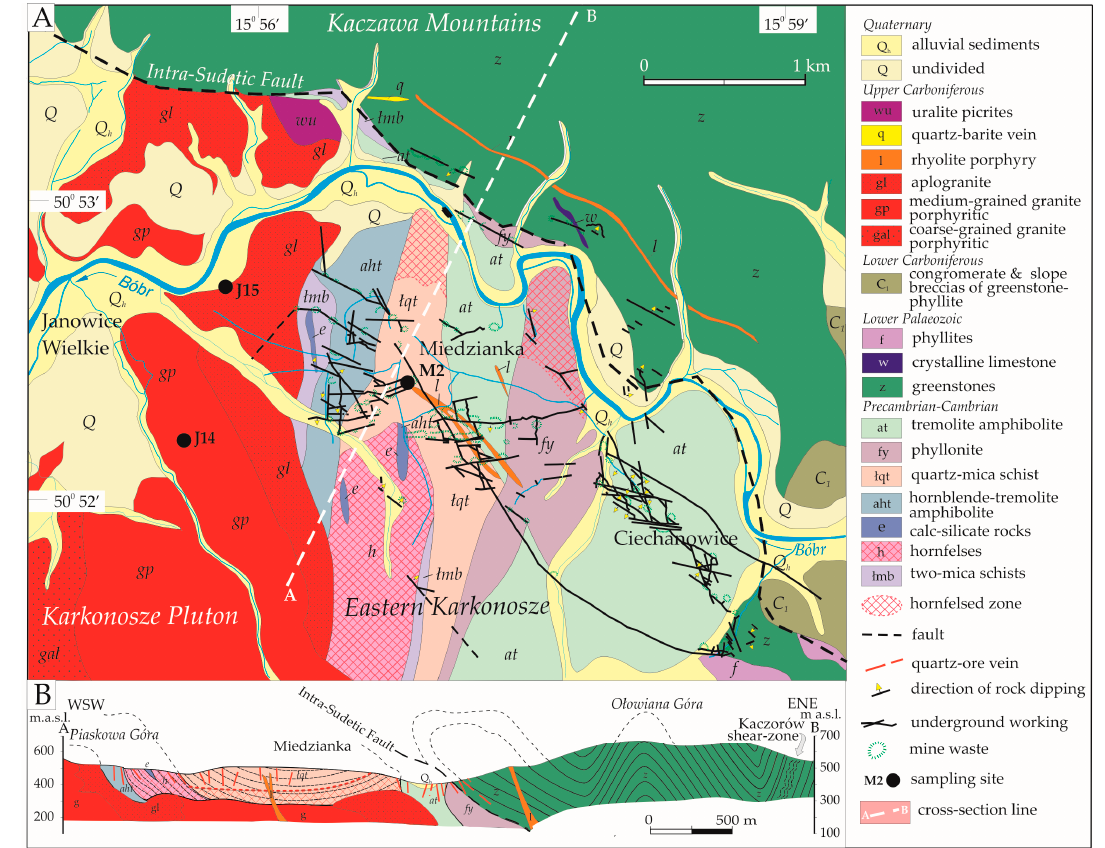
Figure 3. Geological sketch map with sampling sites ( A ) after [66] with mine workings and waste compiled from unpublished mining documents. ( B ) Geological cross-section of the Miedzianka deposit and its surroundings after [66].